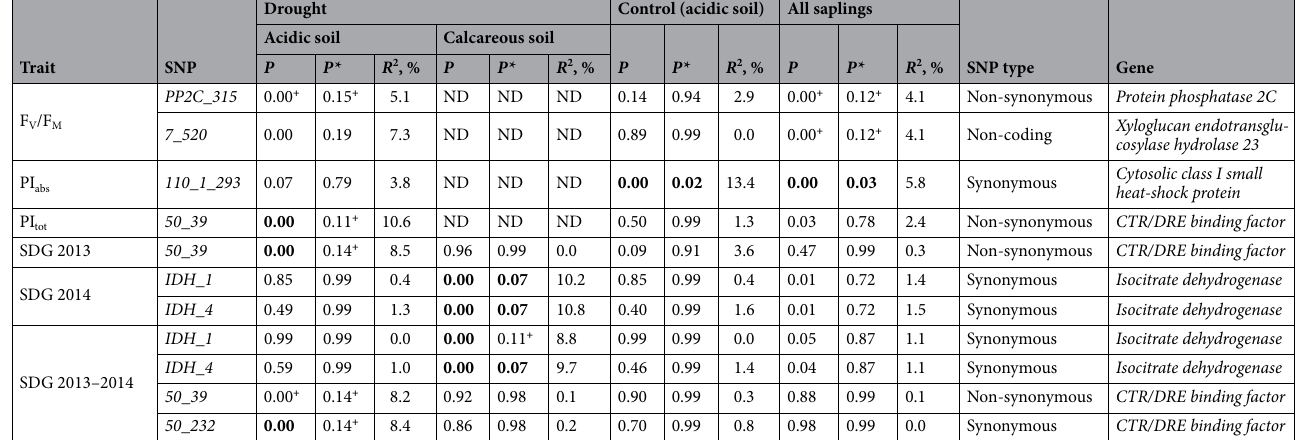
Table 2. SNPs showing significant or close to significant association with chlorophyll fluorescence traits (FV/ FM, PI abs , and PI tot ) and stem diameter growth (SDG) in different experimental conditions and for the pooled individuals (all saplings). P *—adjusted P value; R 2 —percent of phenotypic variation explained by the SNP; ND—not determined; + —close to significance. In bold are P values that were still significant after applying the Bonferroni correction ( P ≤ 0.0014) or after adjusting for a FDR <